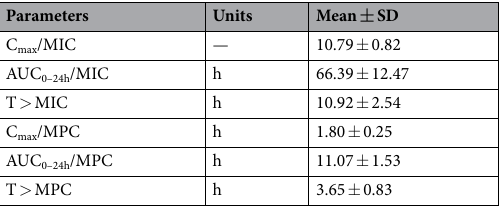
Table 3. PK-PD integration of cyadox in pig ileum fluid agianst Clostridium perfringens after oral administration at a dose of 30 mg/kg (mean ± SD, n =